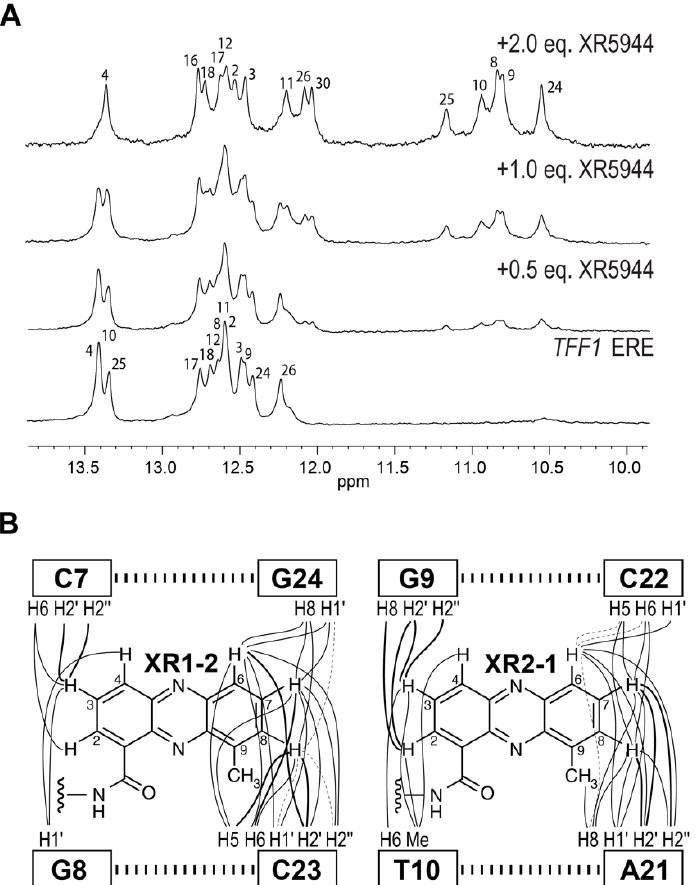
Figure 7. ( A ) The imino proton region of 1D 1 H NMR titration of XR5944 with the naturally occurring TFF1 ERE sequence, which contains a CGG tri-nucleotide spacer. Titration of XR5944 diminishes the imino proton peaks of the free DNA, accompanied by the emergence of a new set of well-resolved upfield peaks of the drug–DNA complex. ( B ) Schematic diagram of intermolecular NOEs between the two strong intercalating XR5944 moieties: XR1–2/XR2–1 and the TFF1 DNA protons. Strong, medium and weak NOE interactions are indicated by bold solid lines, solid lines and dashed lines, respectively.